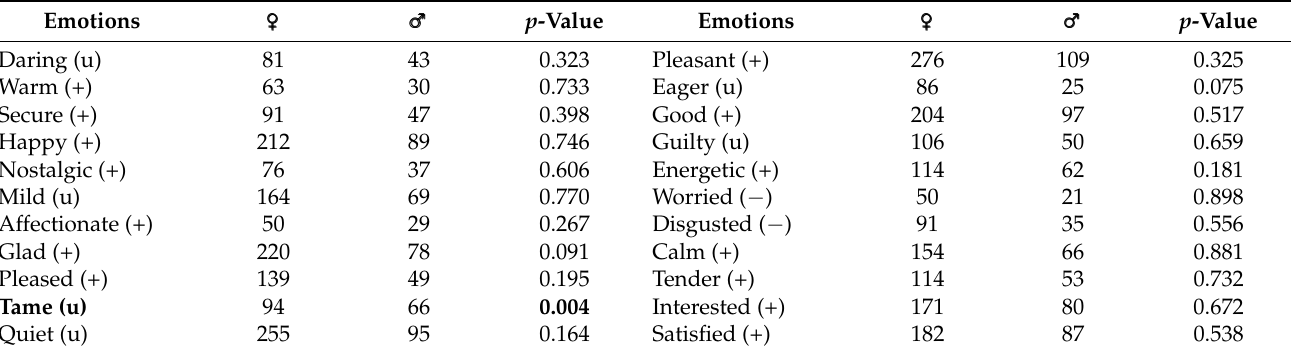
Table 4. Frequency of the emotions of the CATA EsSense Profile ® by gender and results from Fisher’s exact